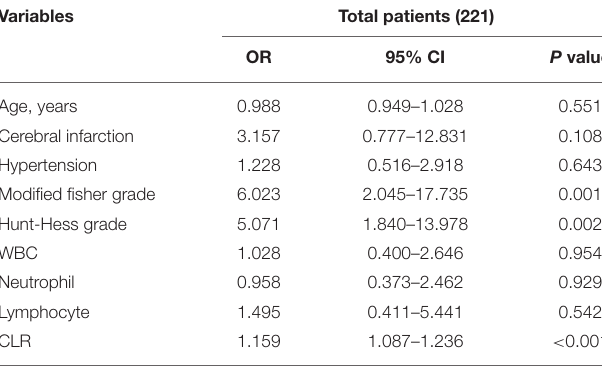
TABLE 2 | Multivariable logistic regression analysis of poor clinical prognosis of aSAH. Variables